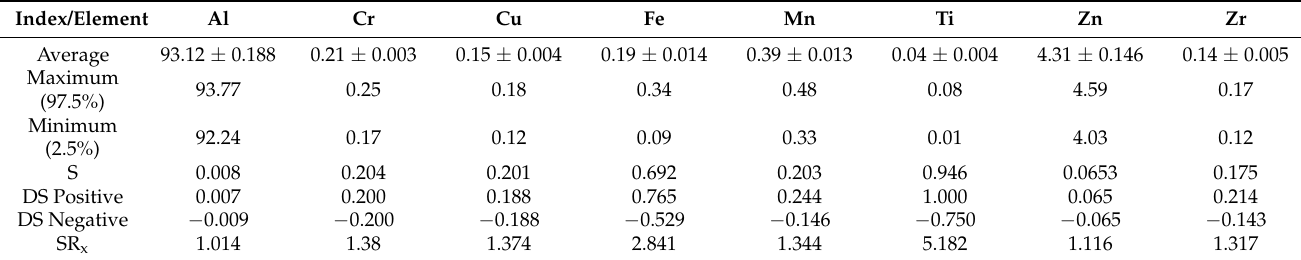
Table 5. Results of statistical distribution analysis of element